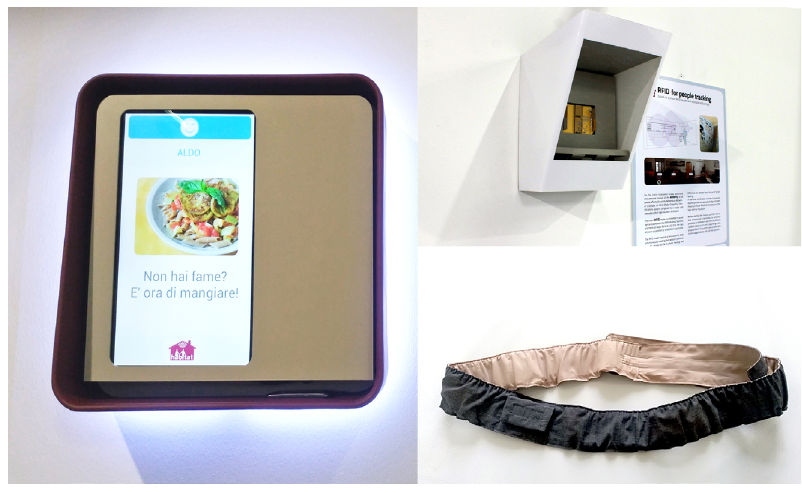
FIG. 3 The digital interface (left); the reader lamp of the indoor localization system (top- right); the wearable inertial sensor for tracking elderly people’s movements (bot- tom-right). Source: M. Marchi,